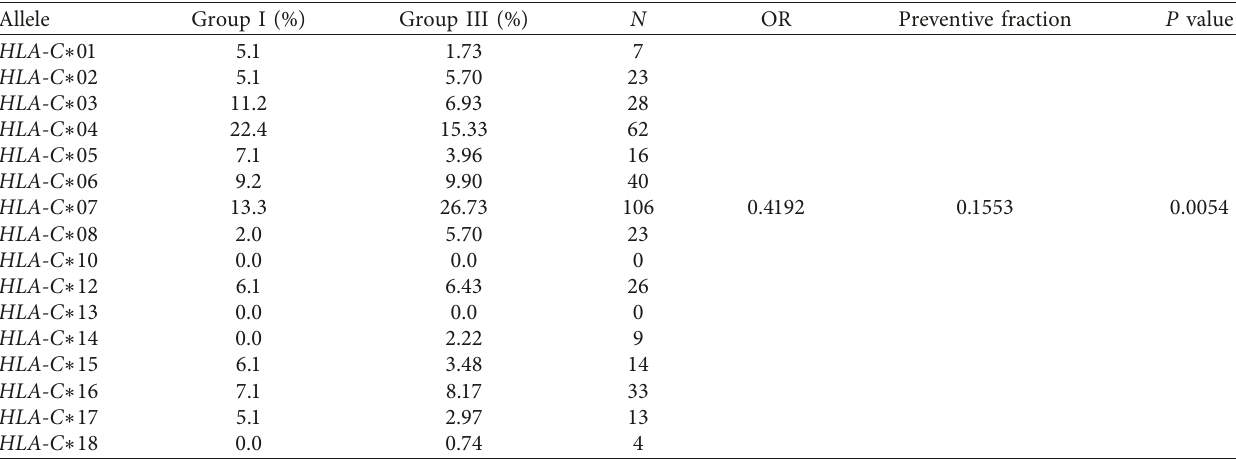
Table 2: HLA-C allele frequencies compared between Groups I (patients with AIDS and CR) and III (healthy HIV-negative individuals). Allele